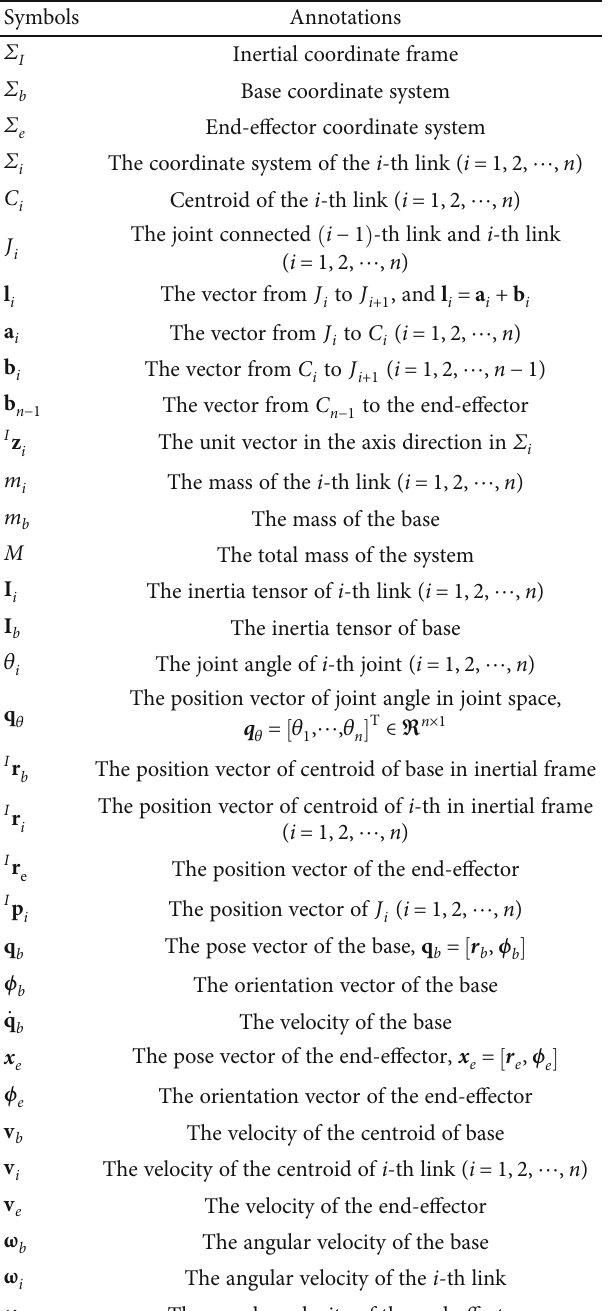
Table 2: Symbols annotations of n -DOF space manipulator without a joint-locked failure.